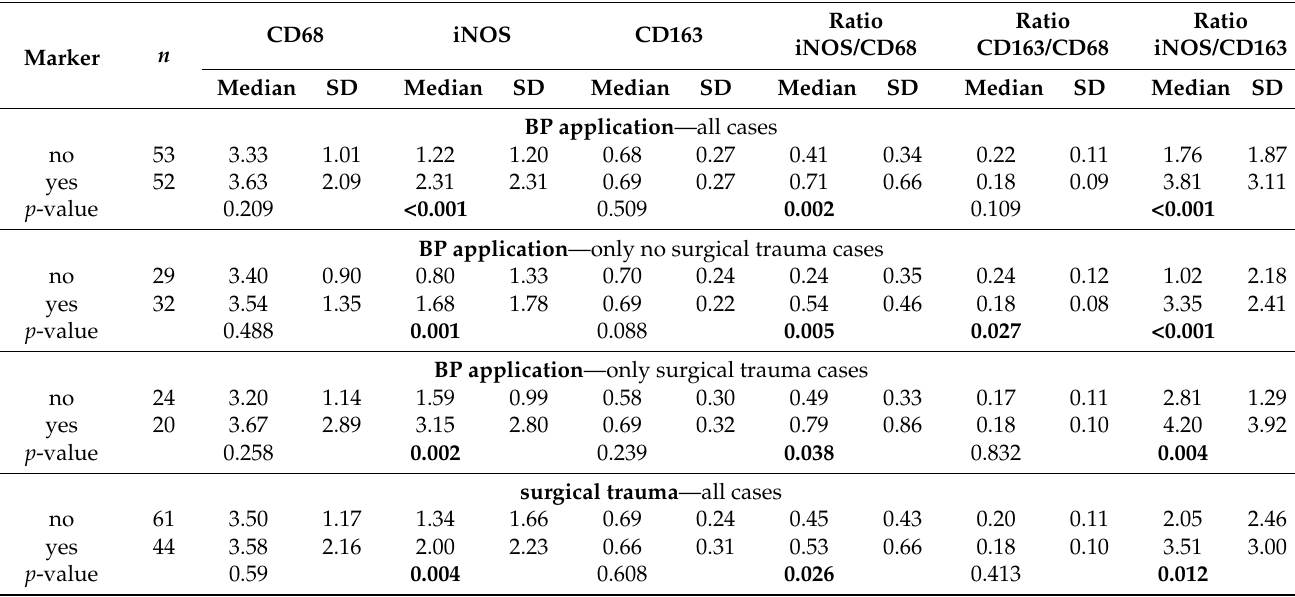
Table 2. CD68. iNOS und CD163 expressions (pos. cells/all cells in %) and iNOS and CD163 to CD68 ratios. p -values were calculated by the